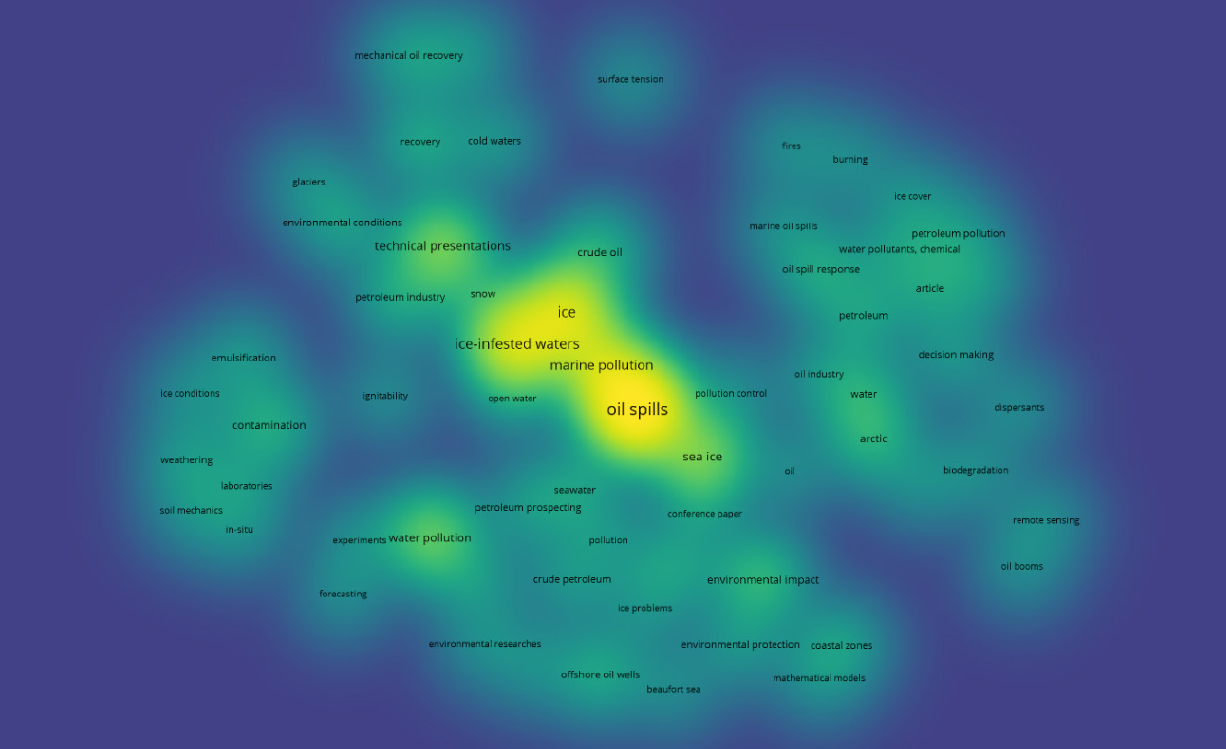
Figure 8. Terms heat map of oil spills publications in ice ‐ infested waters.